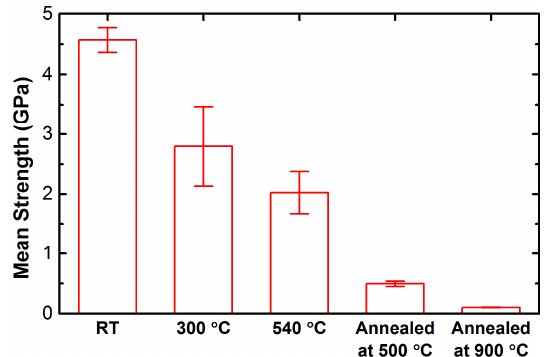
Figure 5. Mean tensile strengths of the bare silica optical fibers annealed at 500 °C and 900 °C respectively and tested at room temperature (26 °C), compared with those of the bare fibers without annealing tested at room temperature (26 °C), 300 °C and 540 °C [26].